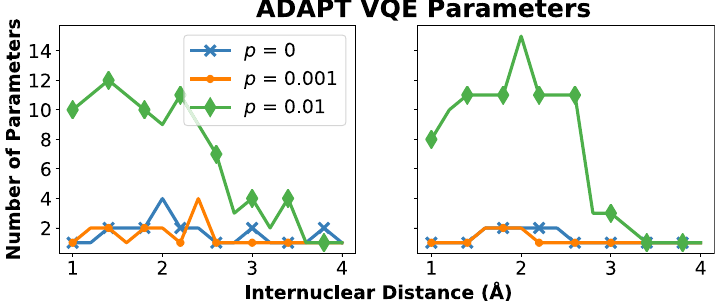
Fig. 9 The number of optimal parameters chosen by the ADAPT algorithm to reach convergence as a function of the internuclear distance, using the COBYLA (left) and L-BFGS (right)